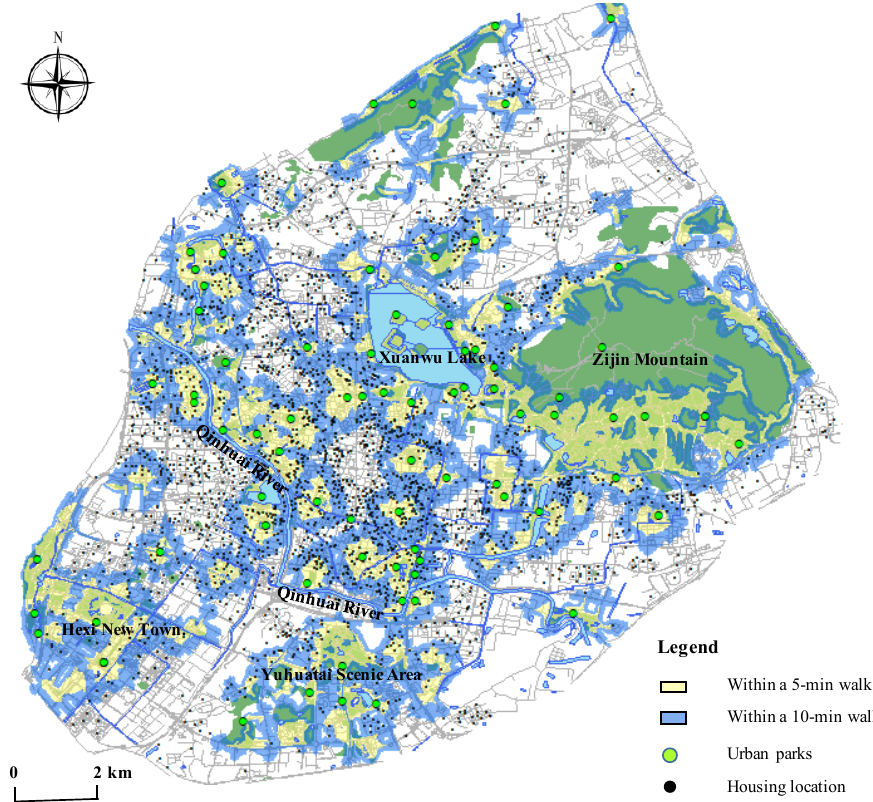
Figure 3. The evaluation of Accessibility among 79 public parks in Nanjing.